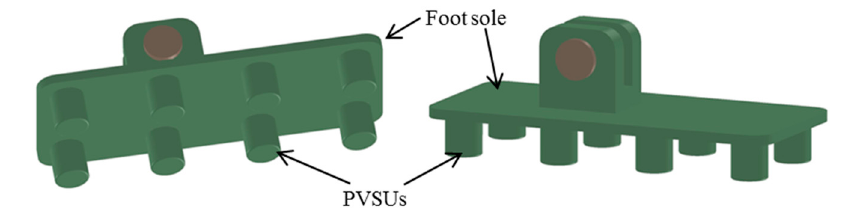
Figure 1. Schematic diagram of the stiffness adjustable foot system.